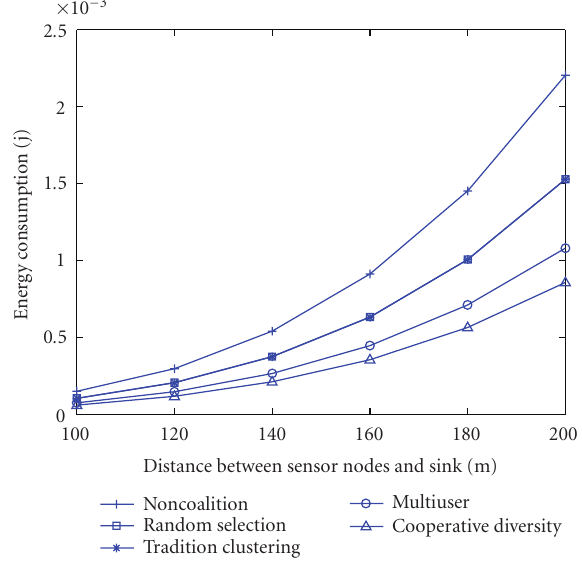
Figure 5: Energy consumption over fading